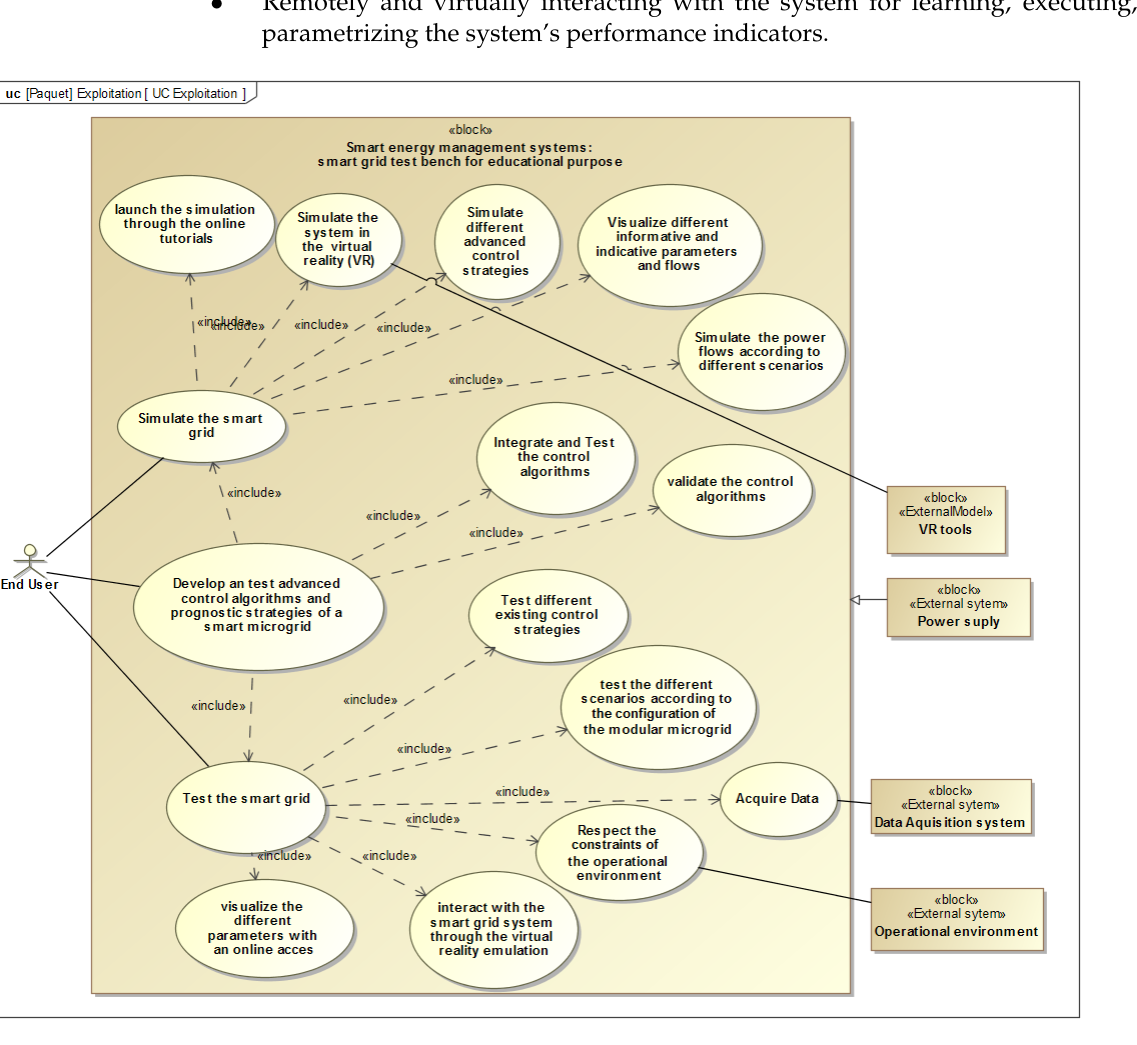
Figure 6. The exploitation use case diagram.